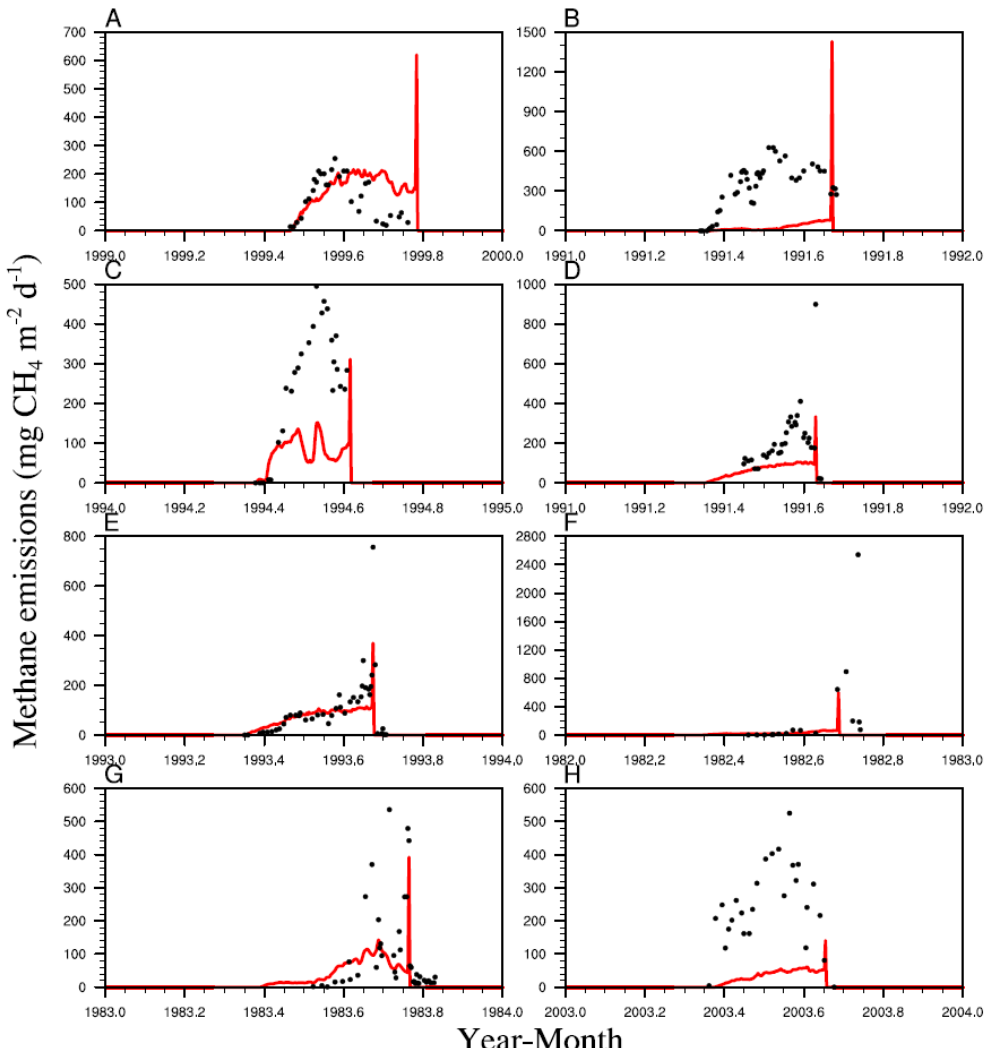
Fig. 10a. Comparison between modeled methane fluxes (red lines) and observation (dots) at each rice paddy site. Note that the scale of y-axis varies between plots. A : Nanjing, China; B : Italy; C :Texas, USA; D : Japan, 1991; E : Japan,1993; F : California, USA, 1982; G : California, USA, 1983; H : Chengdu, China. Please see Table 1 for site descriptions.